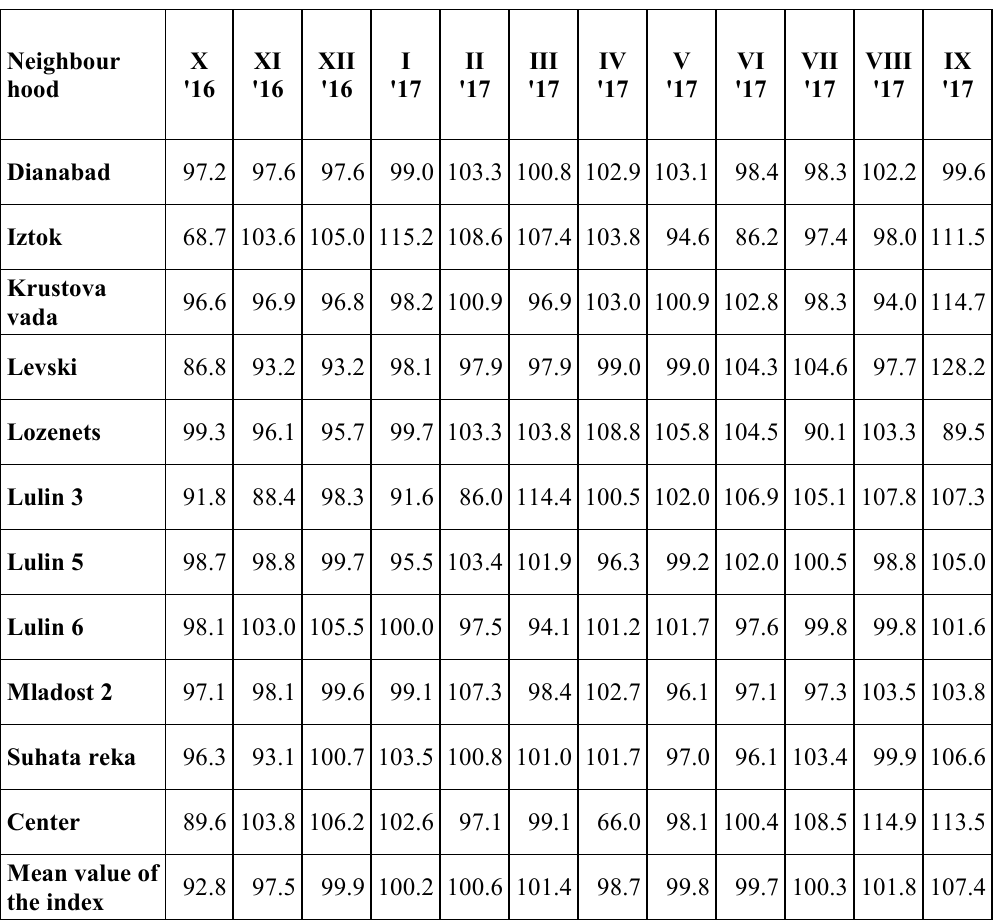
Table 1 . Indices for seasonality in the change of the preferred prices for sale of studios for some neighbourhoods in Sofia in % (compiled by the authors,